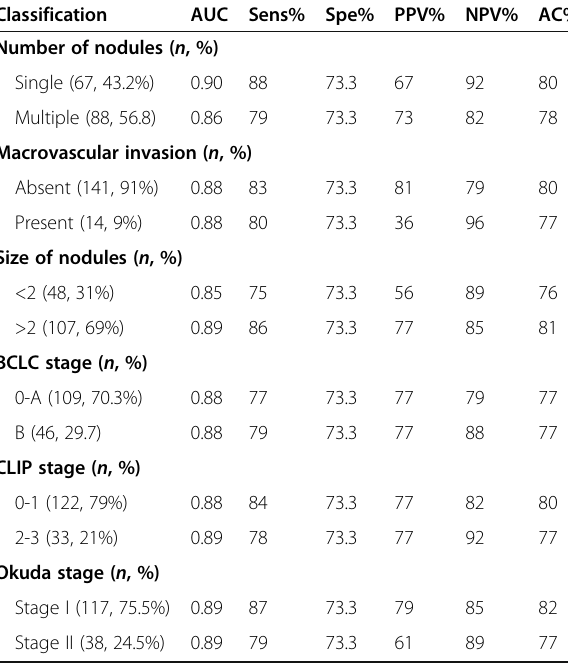
Table 4 Diagnostic power of platelet count to discriminate patients with HCC from patients with cirrhosis in different three staging systems